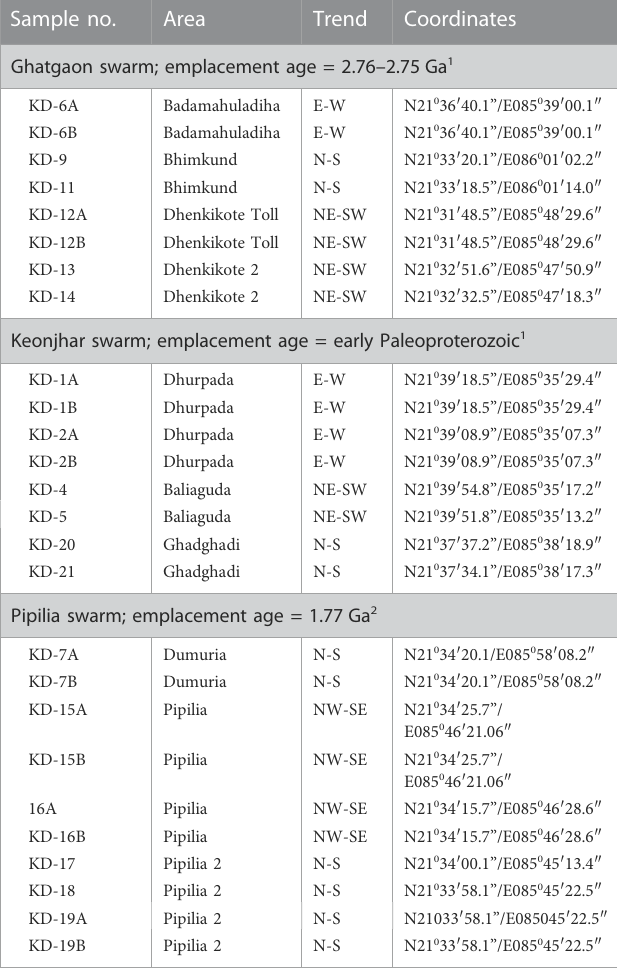
TABLE 1 Sample details of the dyke swarms of Singhbhum craton. Sample no.